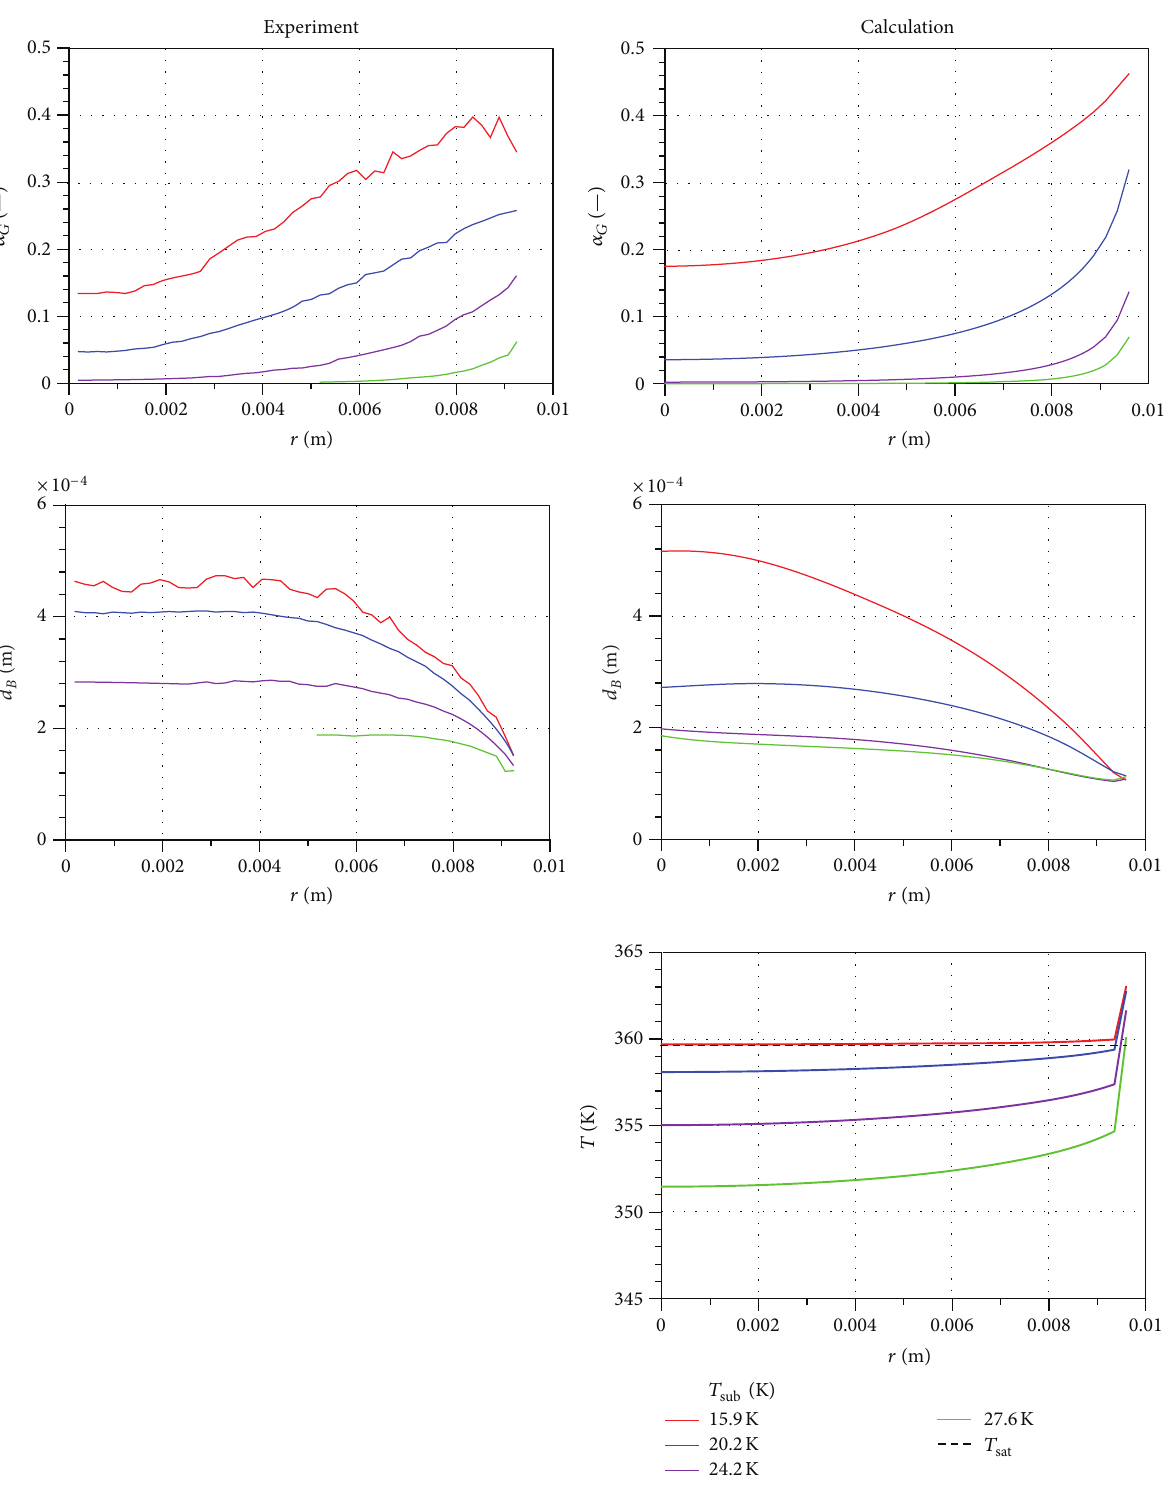
F 10: �as �olu�e fraction� �u��le si�e� and li�uid te��erature �ro�les for test series